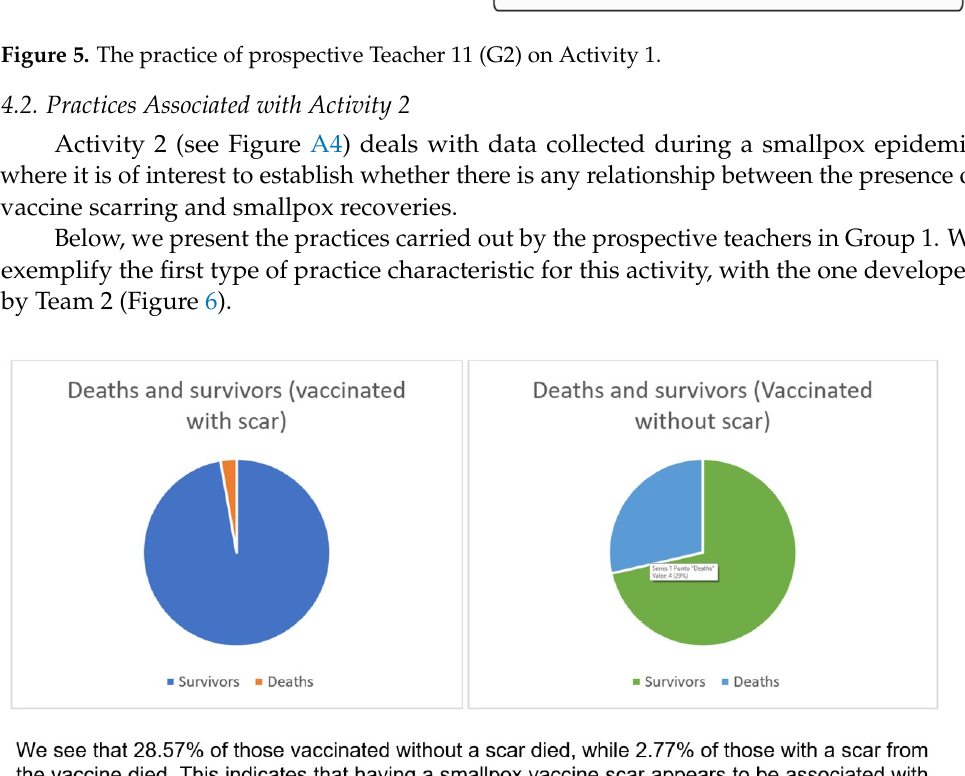
Figure 6. The practice of Team 2 of prospective teachers (G1) on Activity 2.